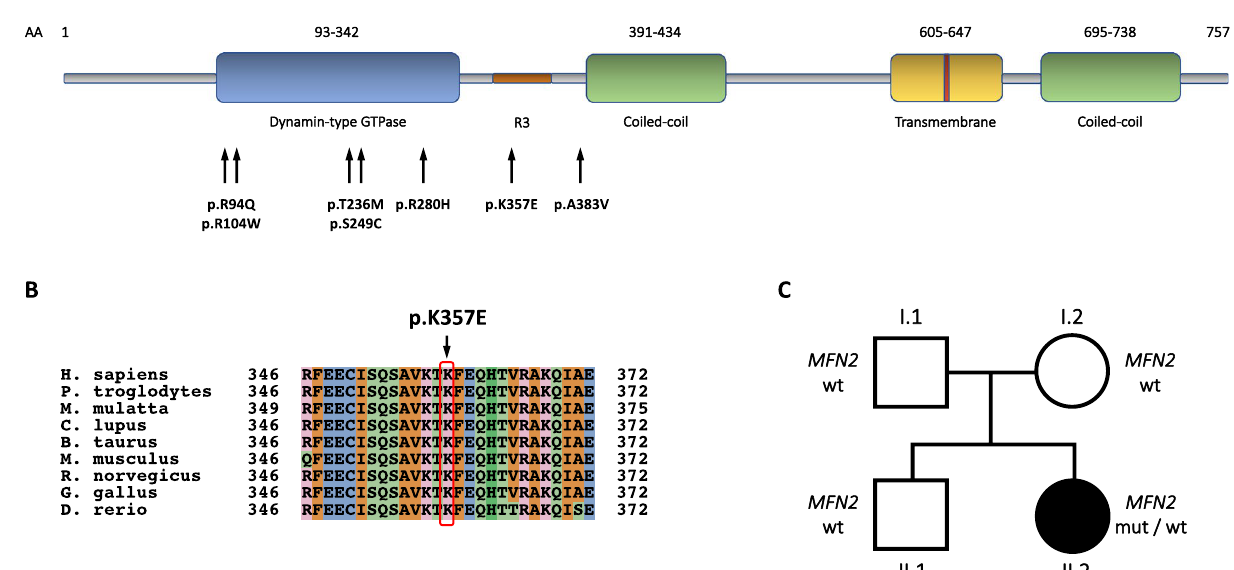
Figure 1. Genetic and bioinformatic analysis. ( A ) Schematic representation of MFN2 protein structure, showing the localization of all the mutations detected in the current cohort ( B ) Conservation among orthologous genes of the K357 amino acid (mutation site), with the colours used by the Clustal Omega multiple sequence alignment program (red = hydrophobic, light blue = positively charged, pink = negatively charged, light green = polar, aquamarine = aromatic, dark green = glycine, orange = proline) 49 ( C ) Pedigree of the patient carrying the p.K357E MFN2 variant. Circles correspond to females, squares to males. The black symbol indicates the proband affected by CMT2A, whereas the white ones are used for healthy